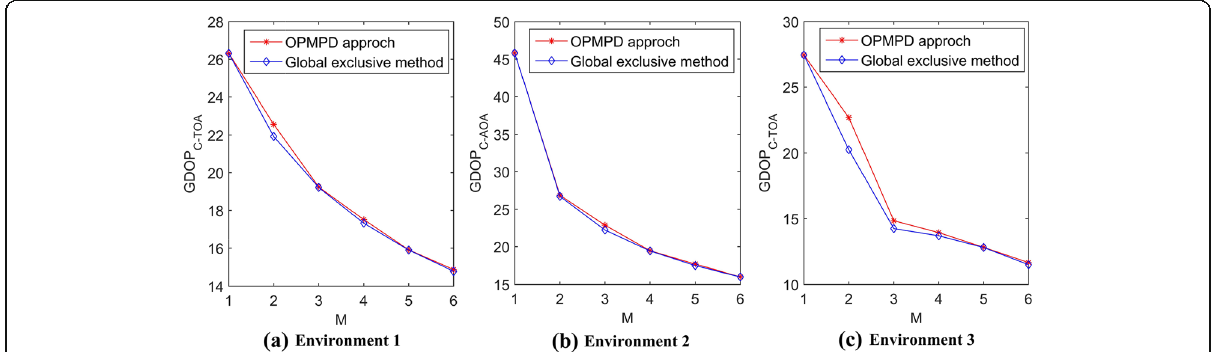
Fig. 9 Accuracy comparison of OPMPD approach and global exclusive method towards AOA-based system. a Environment 1. b Environment 2. c Environment